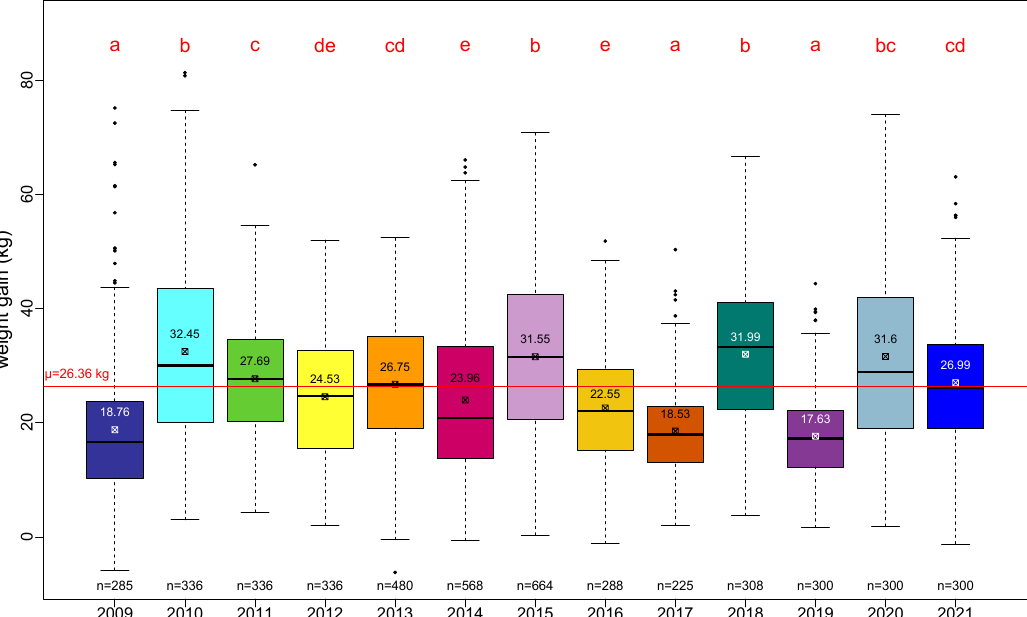
Figure 2. Total weight gain per year across the three regions. Red letters result from a pairwise Student test ( p -value < 0.05). The red line represents the overall average of total weight gain at the colony level. Number in each box plot is the average total weight gain for that year. Number “n=” below each box plot is the number of colonies surveyed for that year. Additionally, the absence of a noticeable trend in the total weight gain over 13 years is consistent with regard to the absence of trends in the number of honey bees or the quantity of capped brood (see Figures 1 and 2).